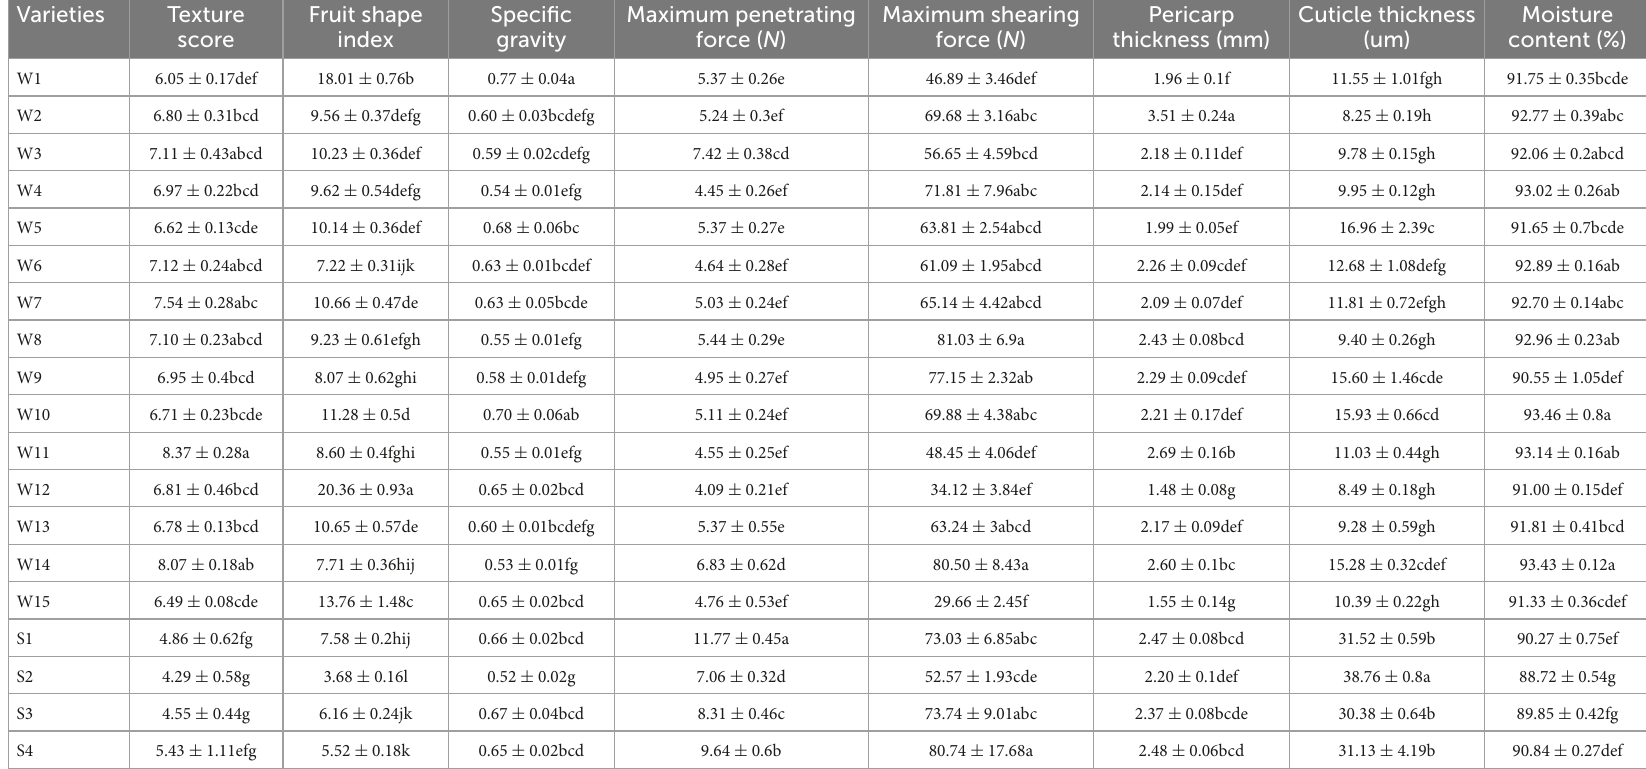
TABLE 1 Fruit traits of the evaluated 19 pepper fruit